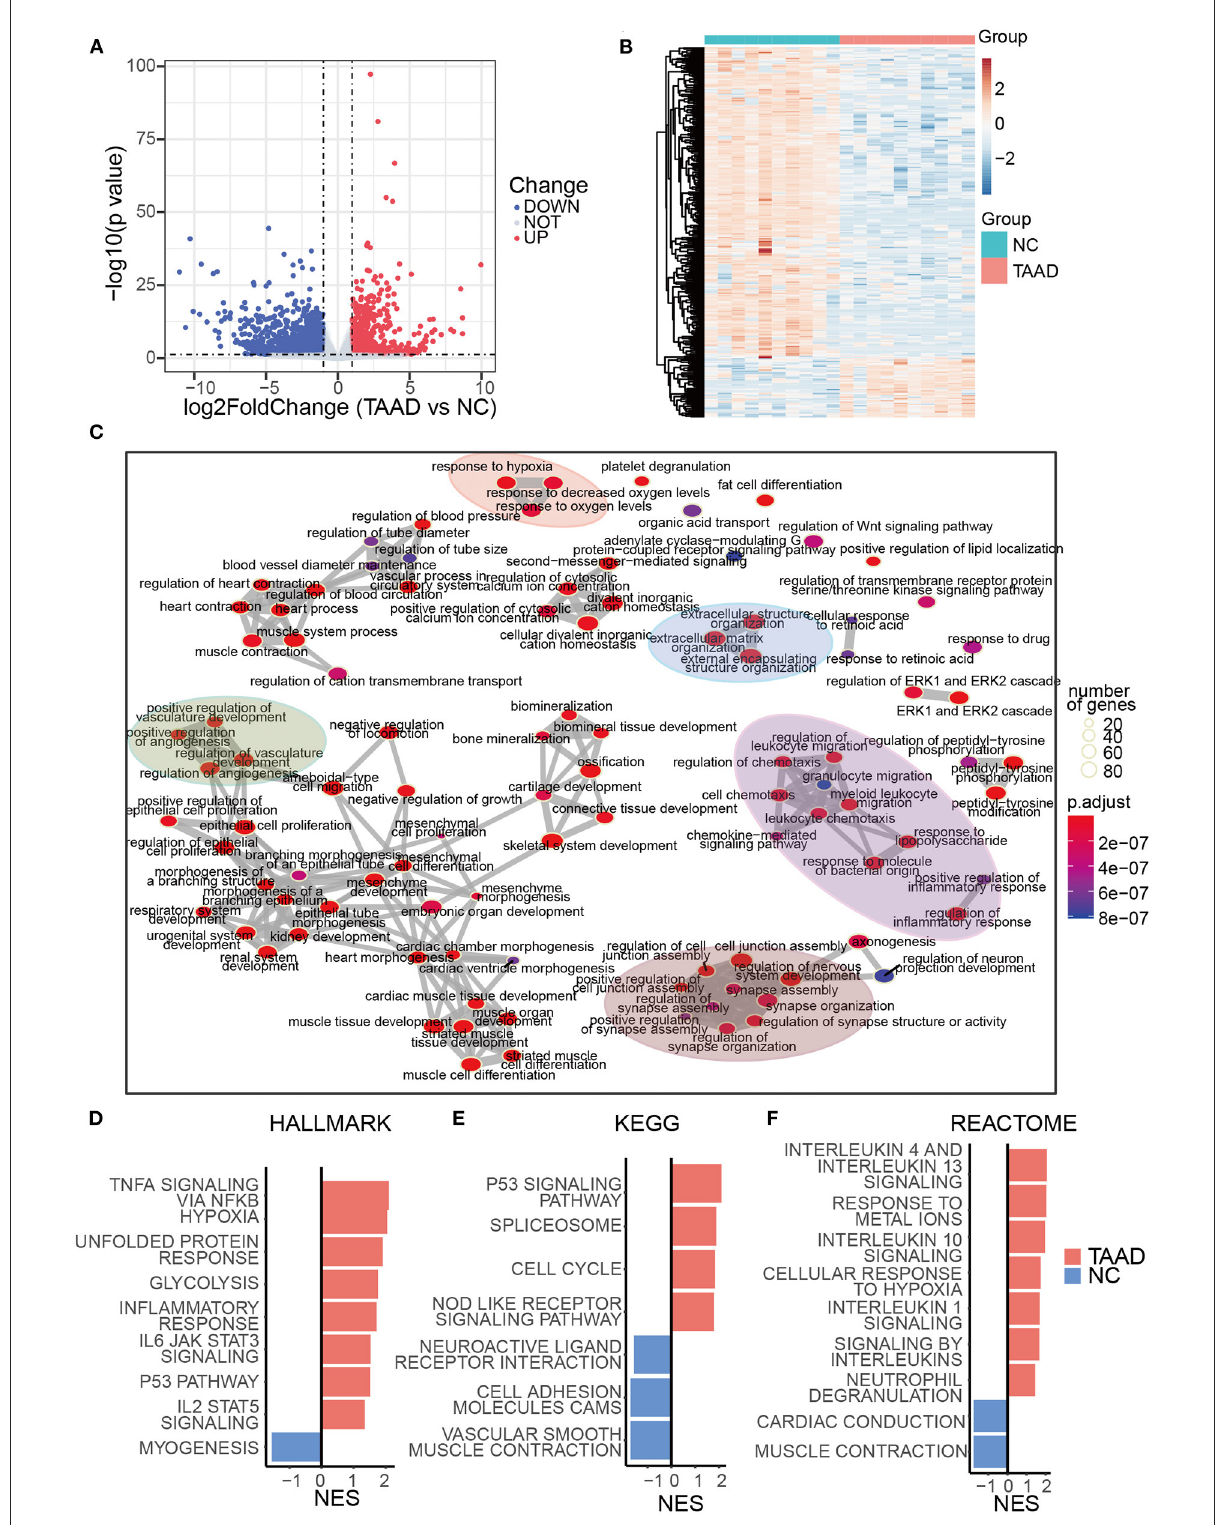
FIGURE1 Transcriptome signatures of TAAD aorta were highly related to elevated inflammation, loss of mesenchyme, and ECM reconstruction. (A) Volcano plots of DEGs. The blue and red parts indicate > 2-fold decreased and increased expression of the dysregulated mRNAs in TAAD tissues, respectively ( P < 0.05). (B) Heatmap represents TAAD DEGs. (C) DEGs enrichment map of enriched terms into a network with edges connecting overlapping gene sets. (D–F) GSEA of HALLMARK (D) , KEGG (E) , and REACTOME (F) gene sets from the Molecular Signatures Database of the Broad Institute, showing the most significantly enriched gene sets in TAAD and normal control aortic tissues and their normalized enrichment scores